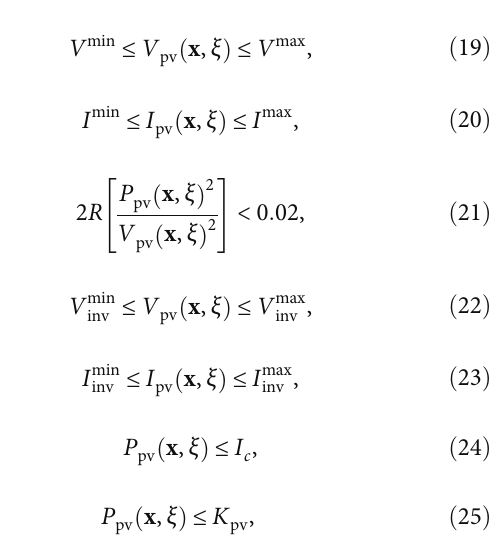
Figure 7: Distance ( D ) e ff ect on SPV